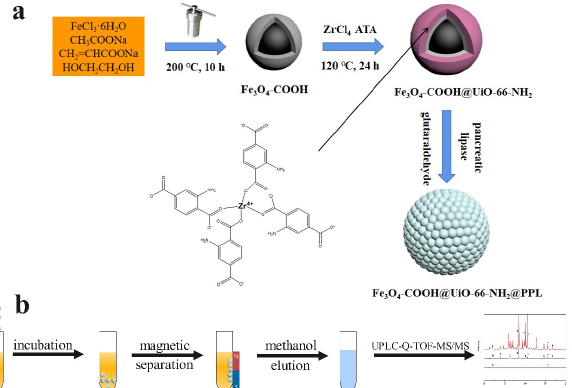
Figure 1. Schematic diagram of the synthesis of Fe 3 O 4 -COOH@UiO-66-NH 2 @PPL ( a ) and ligand fishing process ( b ). 2. Results and Discussion 2.1. Characterization of the UiO-66-NH 2 and Fe 3 O 4 -COOH@UiO-66-NH 2 @PPL 2.1.1. Fourier Transform Infrared Analysis The Fourier transform infrared ( FT-IR) spectra of Fe 3 O 4 -COOH, Fe 3 O 4 -COOH@UiO- 66-NH 2 , PPL, and Fe 3 O 4 @UiO-66-NH 2 @PPL are depicted in Figure 2. As for Fe 3 O 4 -COOH,